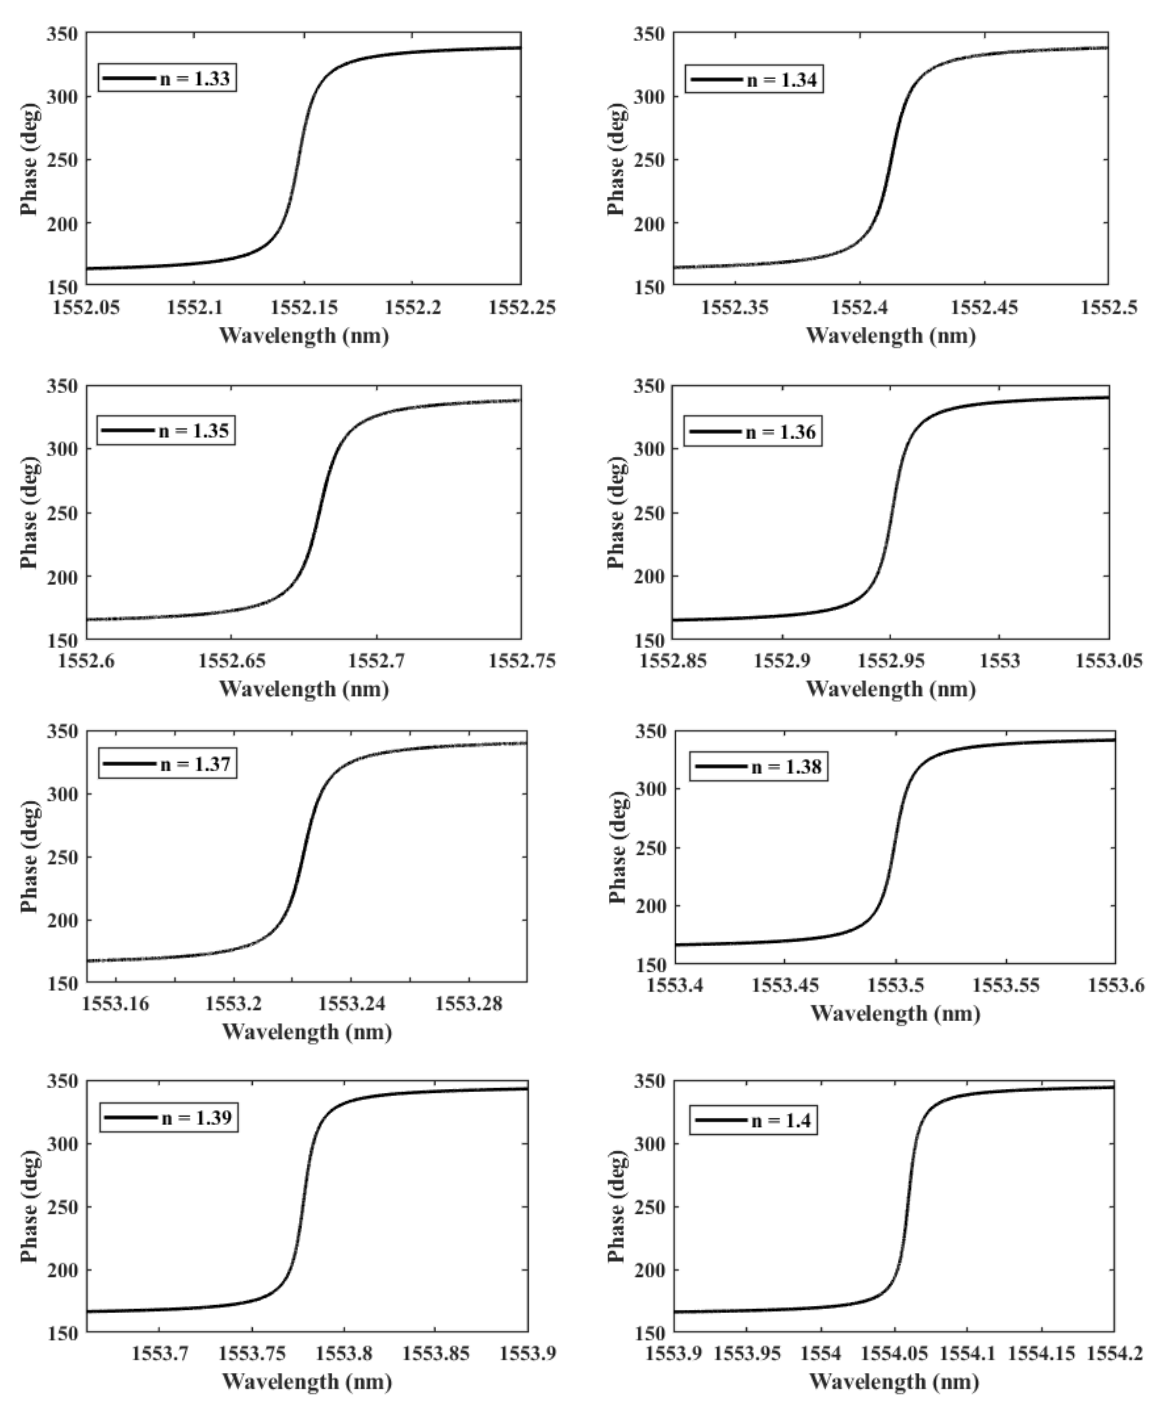
Figure 6. The phase of the transmitted wave as a function of the RI n during the formation of a